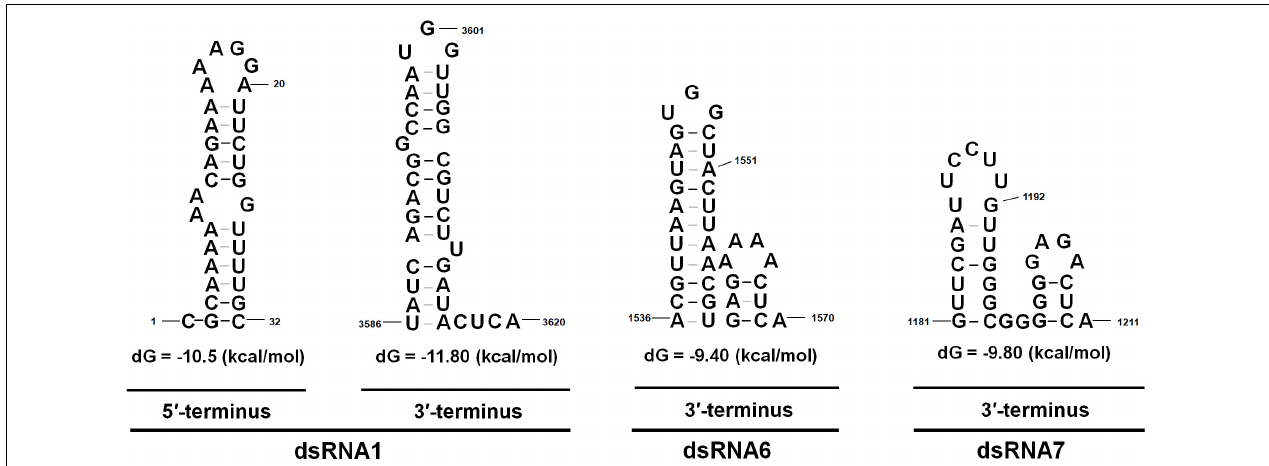
FIGURE 3 | The proposed secondary structures with the lowest energy of CfCV1. The 5 (cid:48) terminus of the coding strands of the seven dsRNAs were predicted to fold into semblable stem-loop structures, as depicted for dsRNA1. Whereas, the stem-loop structures of the 3 (cid:48) terminus of dsRNA6 and dsRNA7 differed from that of dsRNA